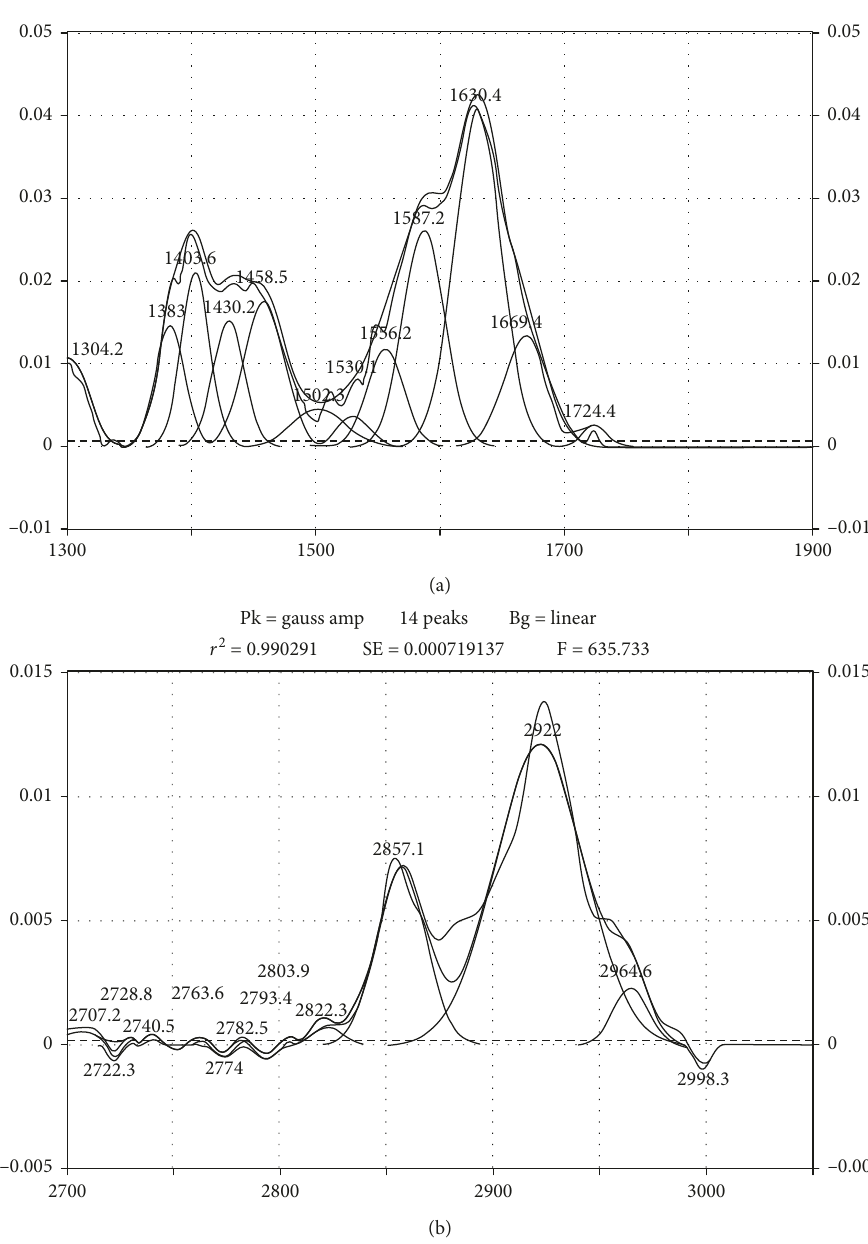
Figure 2: Curve-fitted results of 3000–2800cm